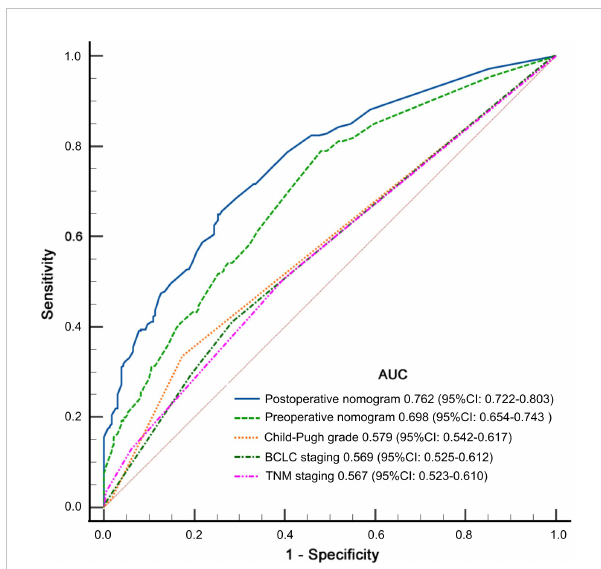
FIGURE 4 Receiver operating characteristic curves of preoperative and postoperative predictive models, and Child – Pugh grade, tumor-node- metastasis (8th TNM) staging, and Barcelona Clinic Liver Cancer (BCLC) staging for predicting non-textbook outcomes